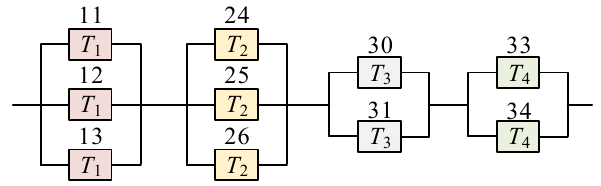
Figure 9. Fault tree of the wind turbine drivetrain.